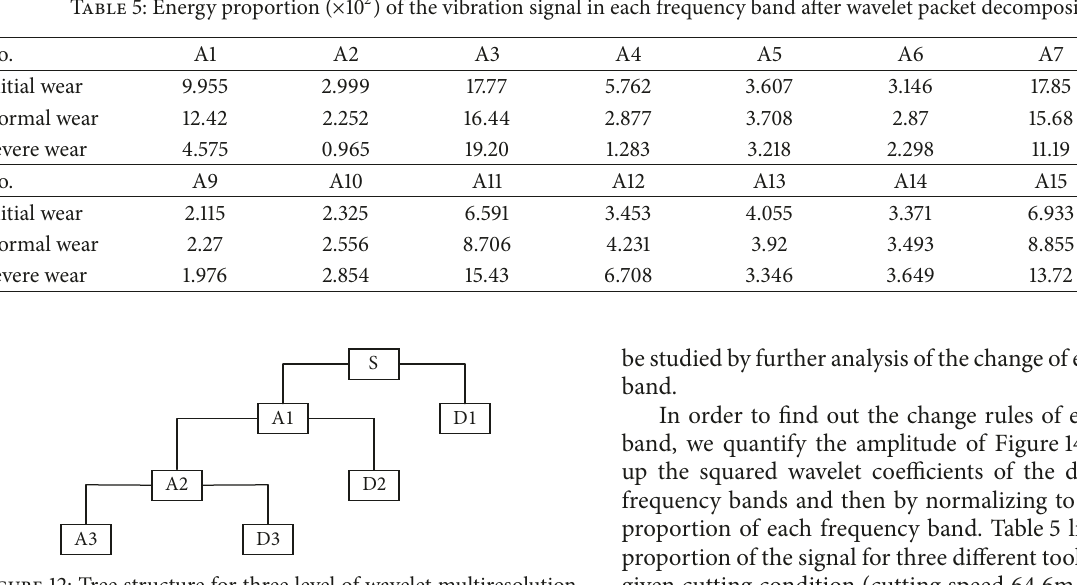
Figure 12: Tree structure for three level of wavelet multiresolution